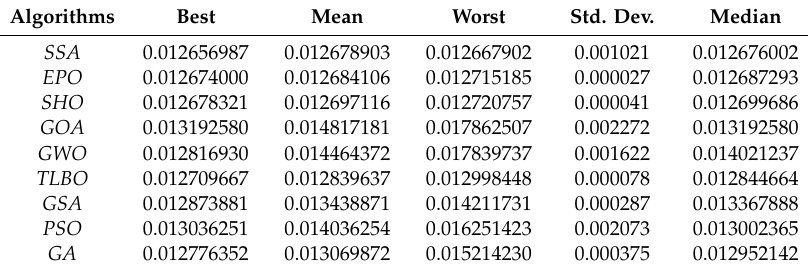
Table 12. Statistical results for tension / compression spring design problem.